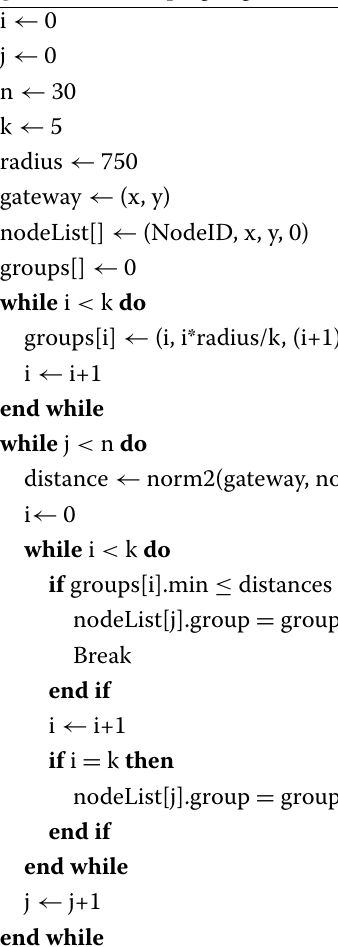
Algorithm 2 Grouping